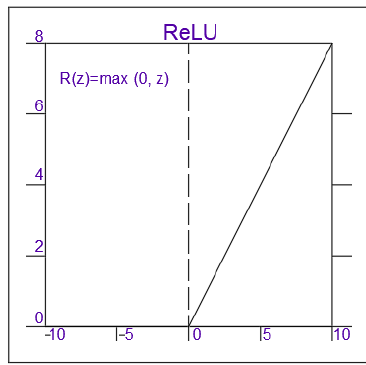
Figure 4. Activation function